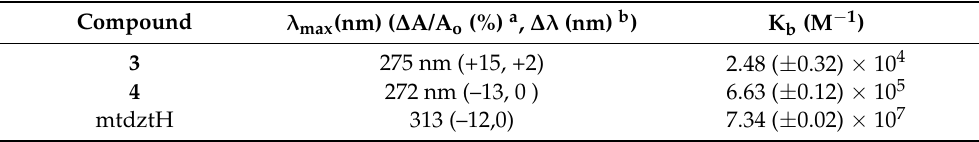
Table 3. Spectral changes in UV absorption bands of compounds 3 , 4 and mtdztH in DMSO solutions ( ∼ 2.5–5 × 10 − 5 M) upon addition of increasing concentrations of CT DNA: wavelength of UV absorption band maximum ( λ max , in nm), percentage of hyper-/hypochromism ( ∆ A/A o , in %), blue/red shift of λ max ( ∆ λ , in nm) and CT DNA binding constants (K b , in M − 1